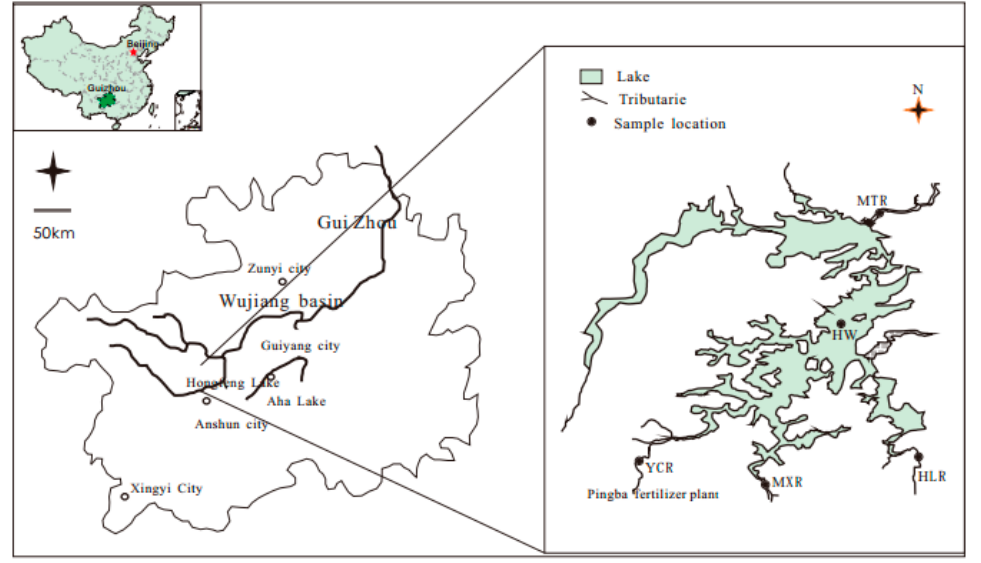
Figure 1. Location and sampling map of Hongfeng Lake, southwestern China.